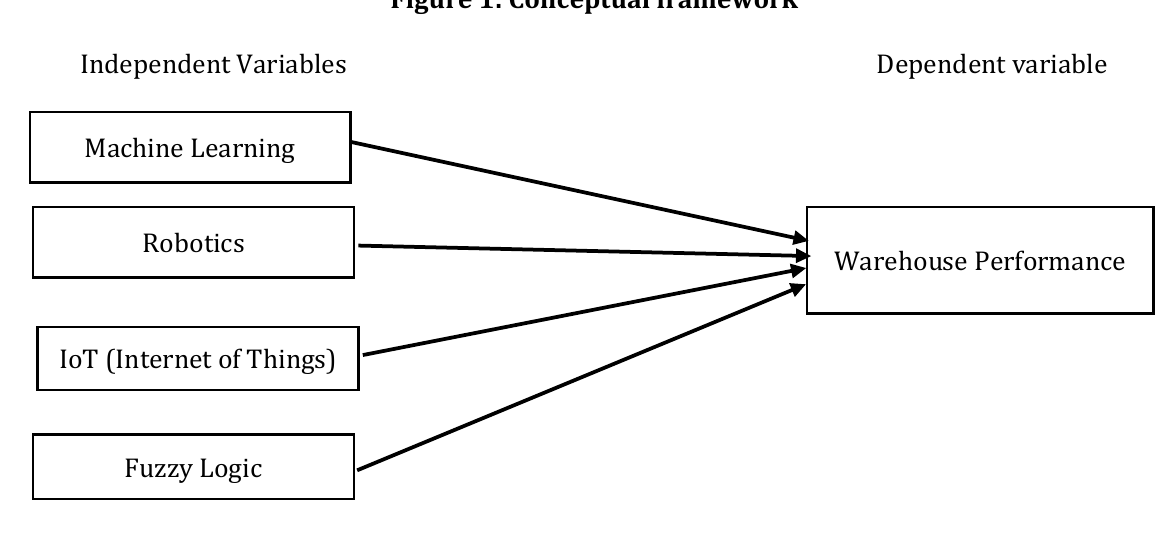
Figure 1: Conceptual framework